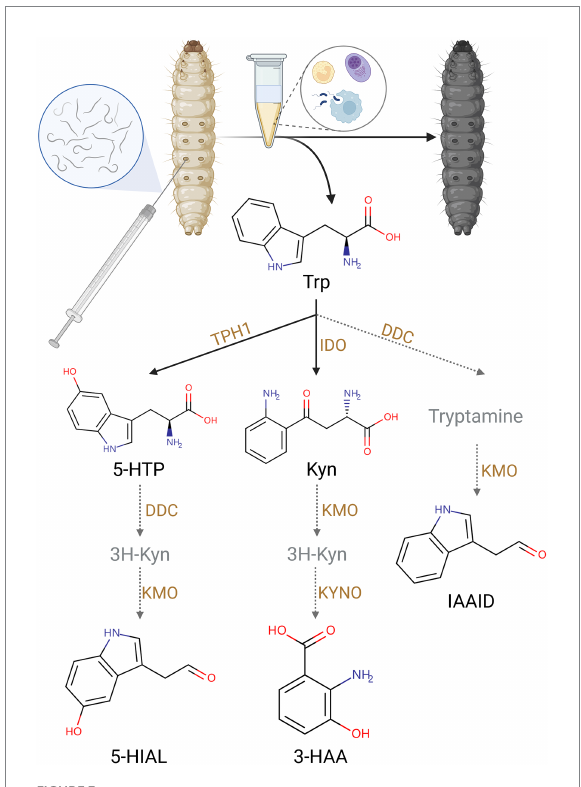
FIGURE 3 The upregulation of Trp metabolites by injection of S. feltiae - X. bovienii (Created with BioRender.com).